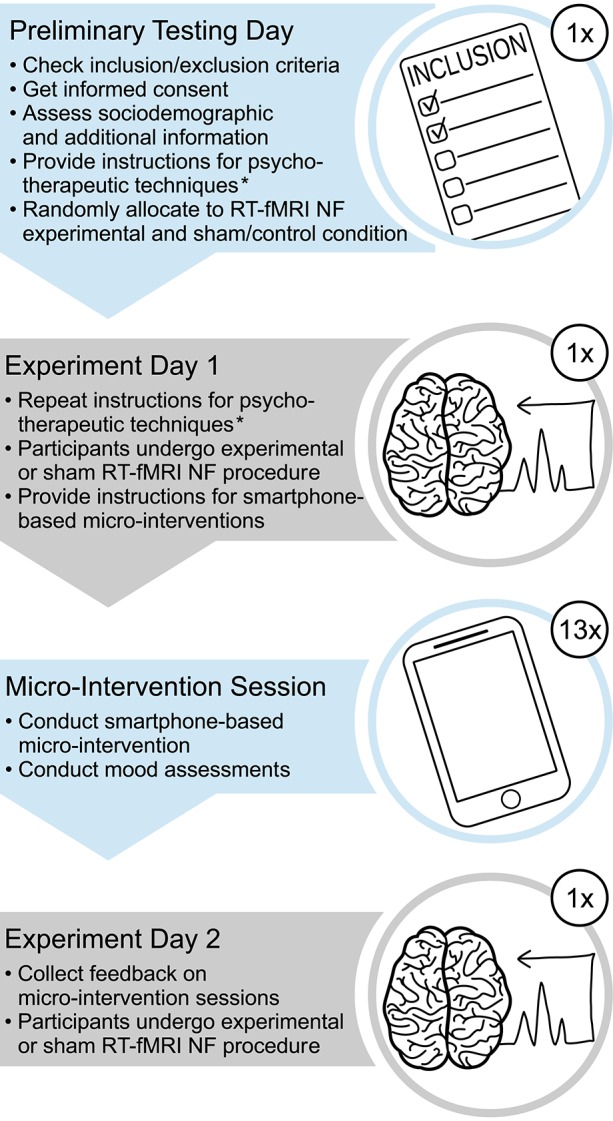
Outline of the larger study. The data presented here were collected during the preliminary testing day and the smartphone-based micro-interventions, with the exception of the feedback on the micro-interventions that was collected before the RT-fMRI NF procedure on experiment day 2. *We instructed participants in four psychotherapeutic techniques, first at the preliminary testing day, then at the beginning of the session at experiment day 1, and briefly reiterated these instructions at the end of this session; RT-fMRI NF, real-time functional magnetic resonance imaging neurofeedback.